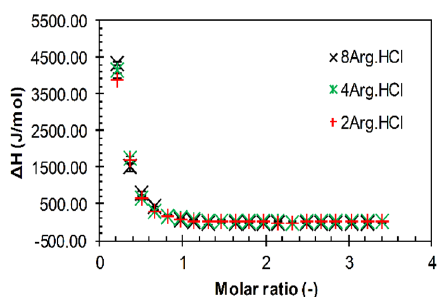
Figure 5. Isothermal titration calorimetry (ITC) records for the titration of various arginine oligomers in hydrochloride form into a 1540 kDa hyaluronan solution in water (25 °C).